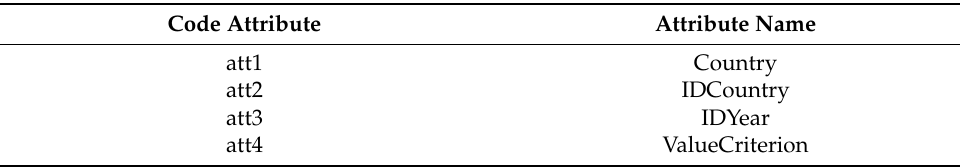
Table 5. OECD country risk: attributes of the time